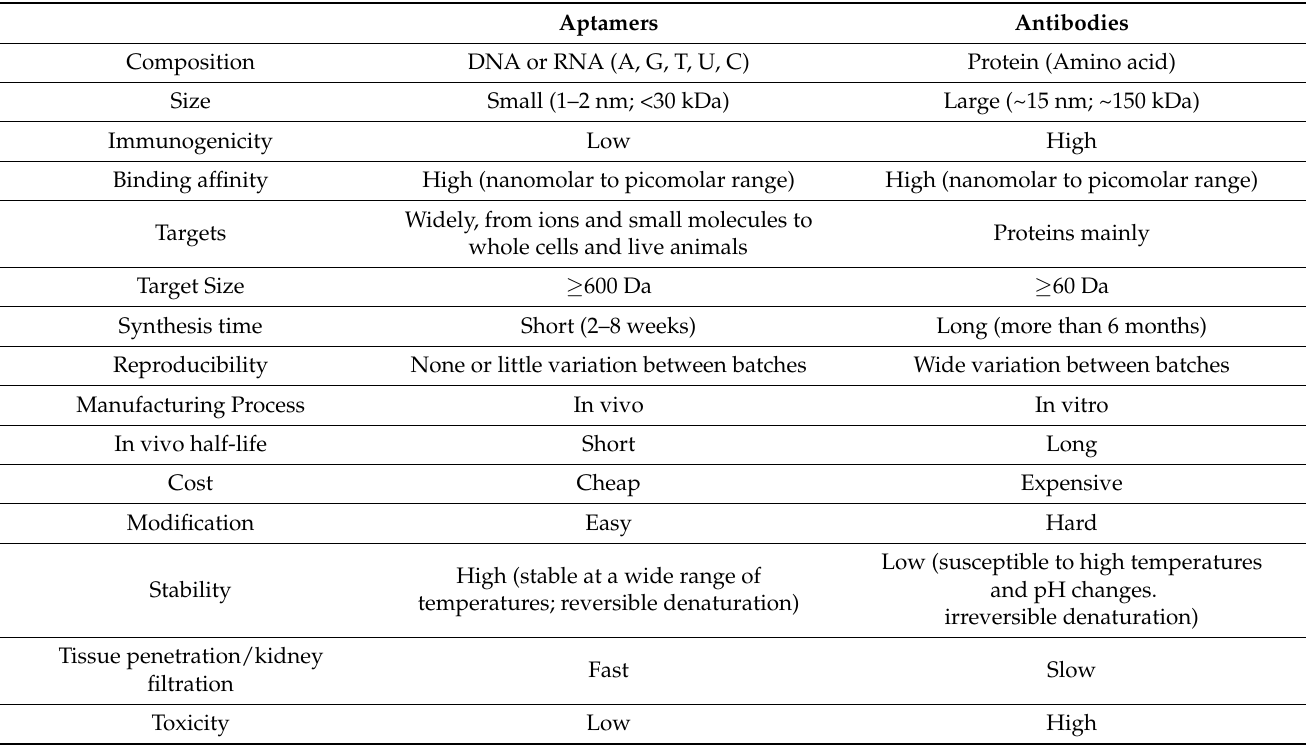
Table 1. A comparison between aptamers and antibodies. Aptamers